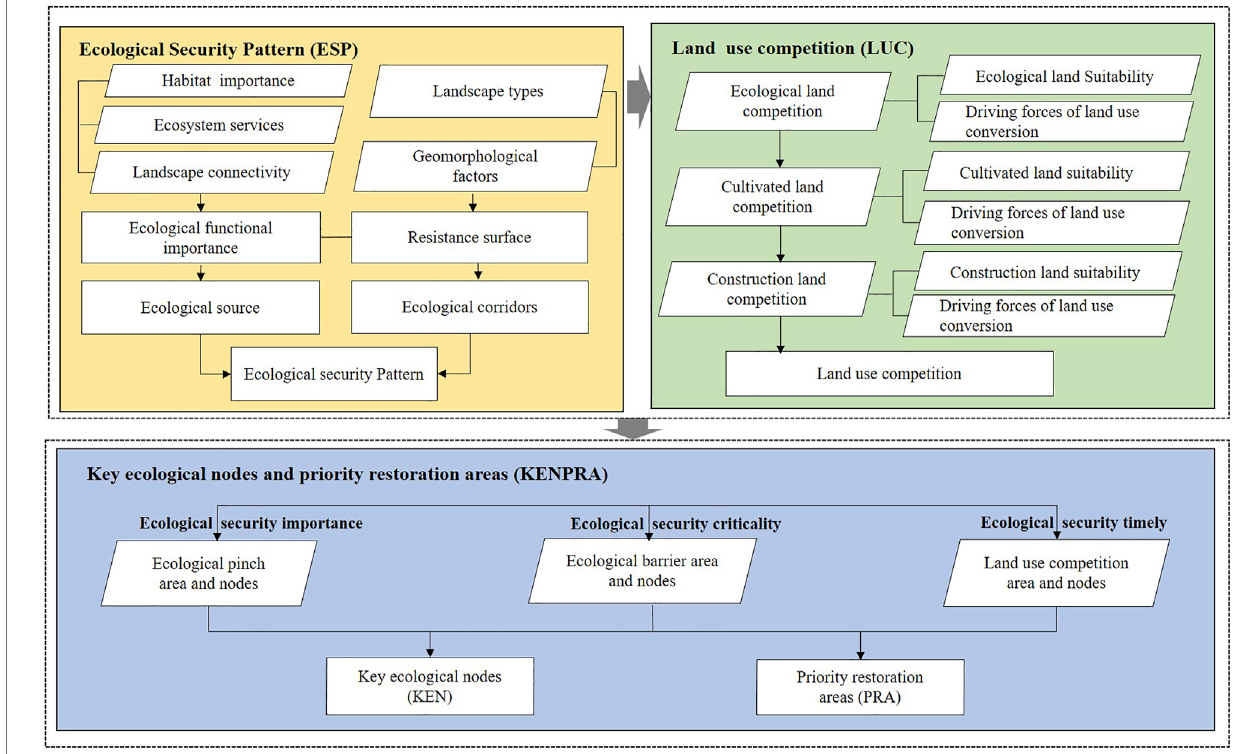
FIGURE 2 | Research framework for optimizing ecological nodes and key areas of restoration.